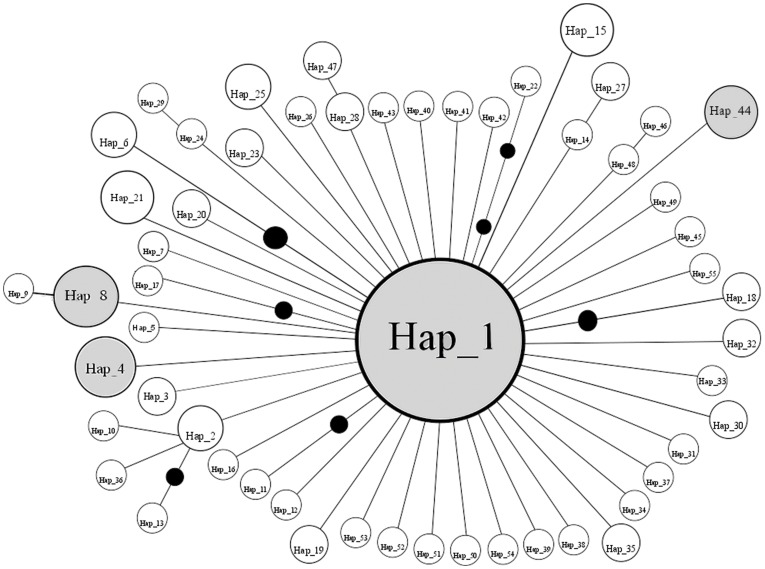
Statistical parsimony network of mtDNA haplotypes.The size of the circle indicates the number of birds with that haplotype. Hap1 was present in all the sampled populations with the exception of BCR (Revelstoke, BC). Black circles are inferred haplotypes.